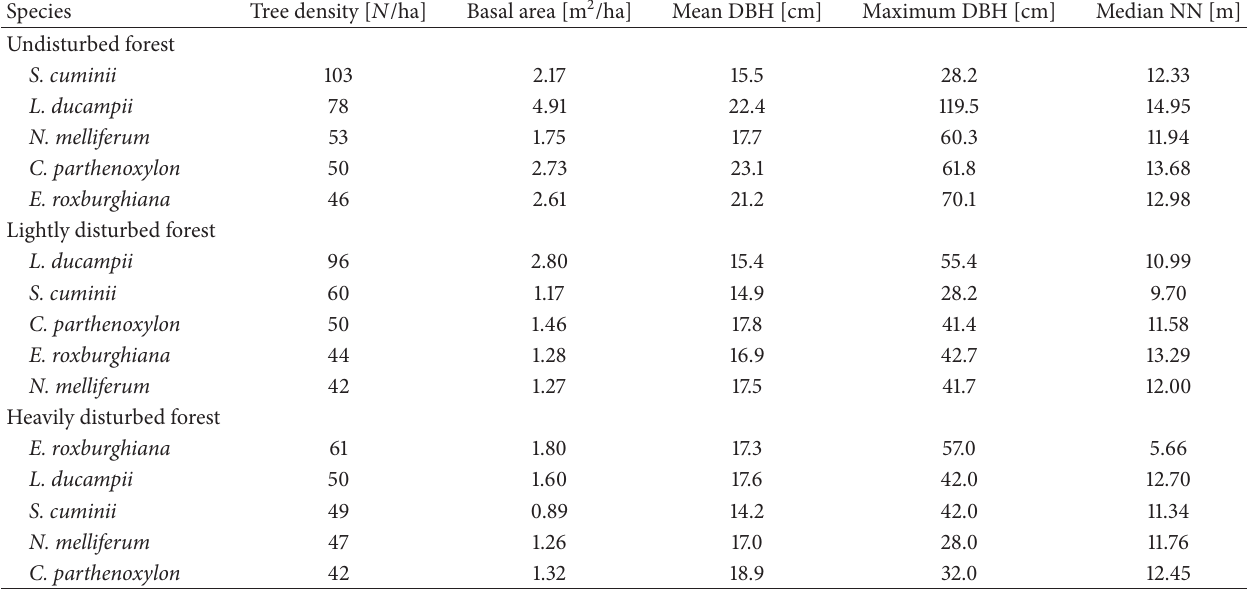
Table 2: The five most abundant tree species of each forest site in Xuan Nha Nature Reserve, Vietnam. Species Tree density [ 𝑁